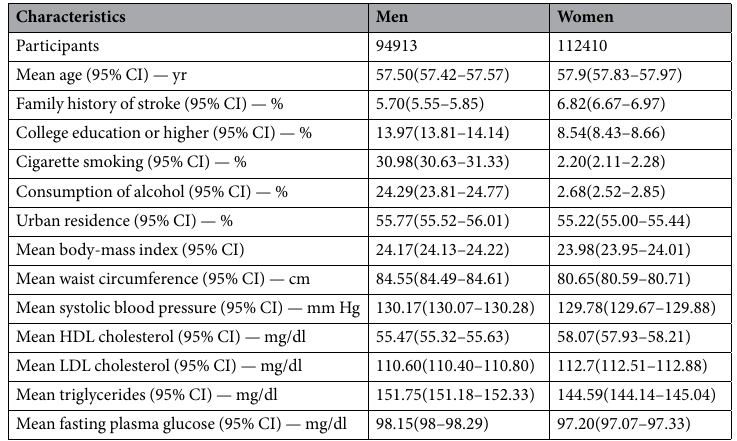
Table 1. General Characteristics of the Participants * . * Abbreviation: HDL denotes high-density lipoprotein; LDL denotes low-density lipoprotein. To convert plasma glucose value to millimoles per liter, multiply by 0.0555. To convert low-density lipoprotein and high-density lipoprotein cholesterol to millimoles per liter, multiply by 0.0259. To convert triglycerides to millimoles per liter, multiply by 0.0113. Body mass index is calculated as weight in kilograms divided by the square of the height in